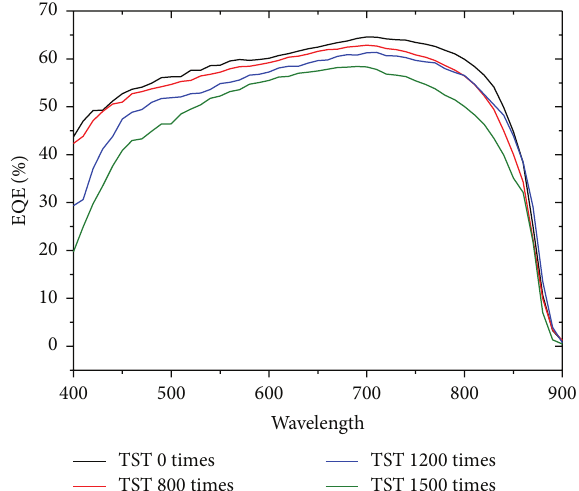
Figure 9: EQE responses of thin-film solar cell grown on electro- plated Ni substrate with different thermal shock times.